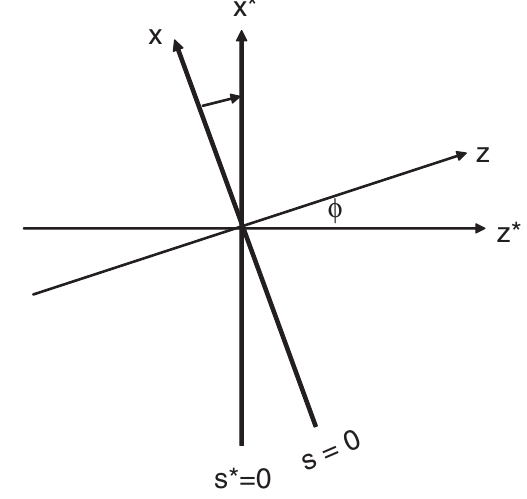
FIG. 7. A rotation around the y axis presented by a Lie operator.